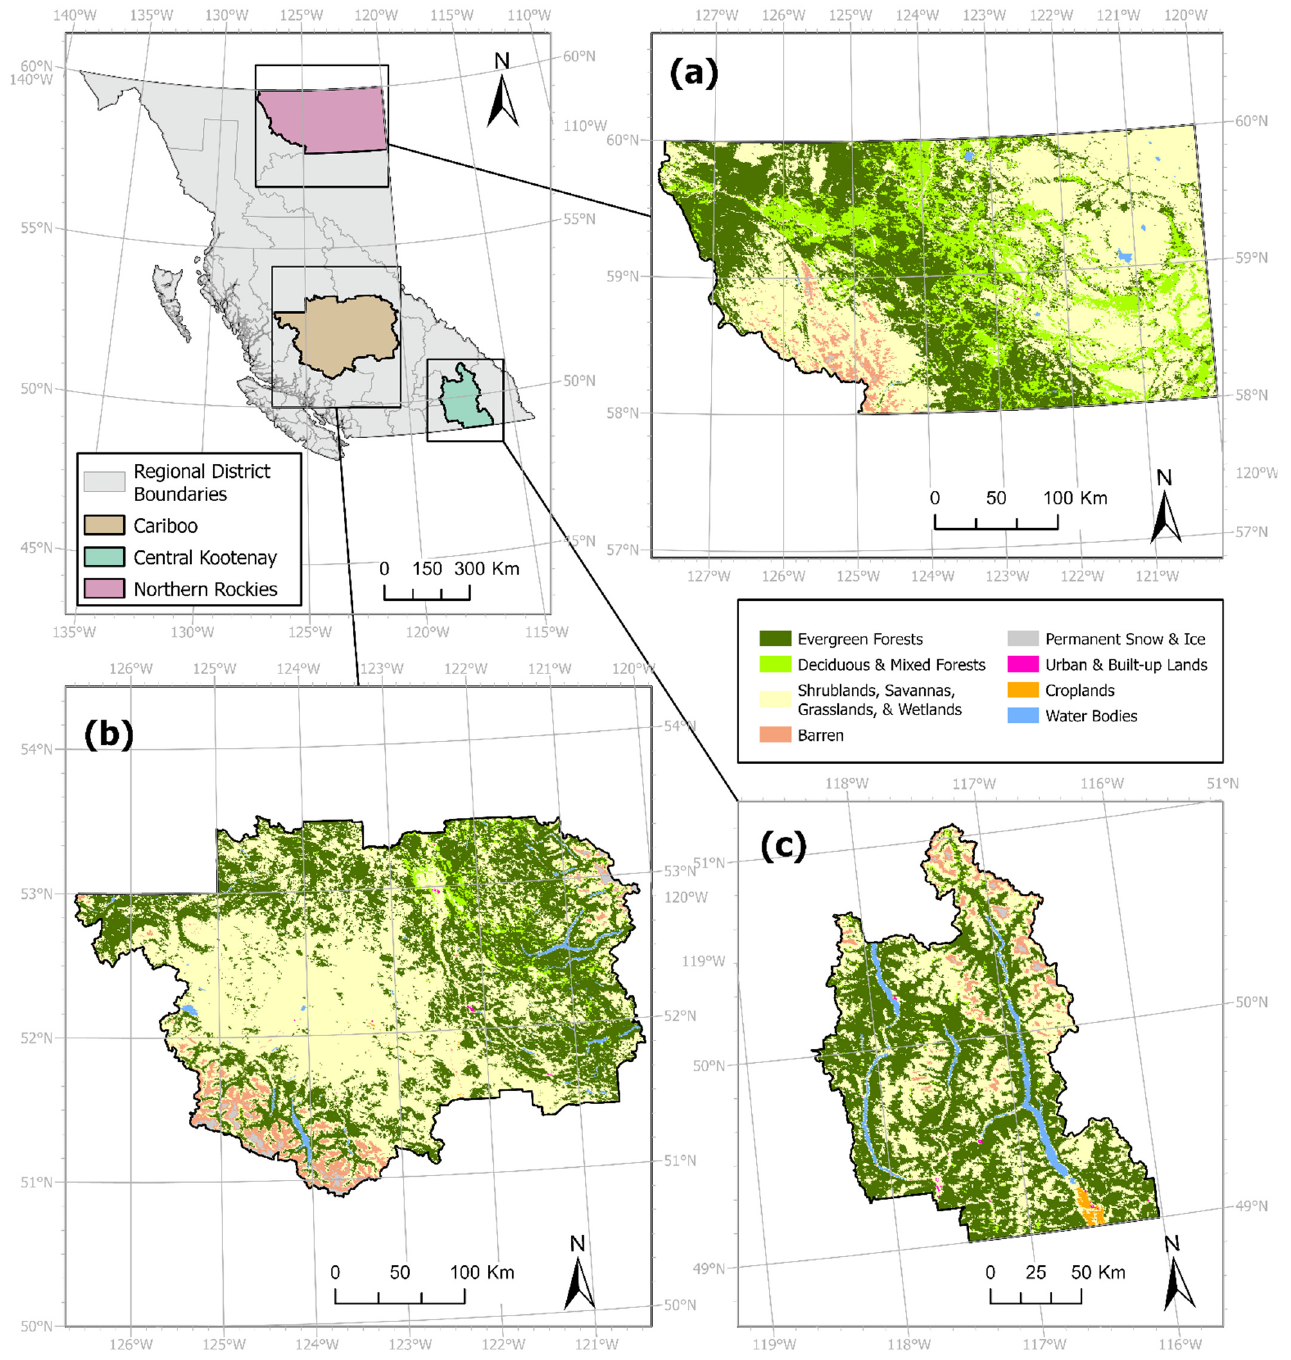
Figure 2. 2001 land cover of the additional study areas of ( a ) the Northern Rockies Regional Municipality, ( b ) the Cariboo Regional District, and ( c ) the Regional District of Central Kootenay. Data are displayed with the NAD 1983 BC Environment Albers projected coordinate system.